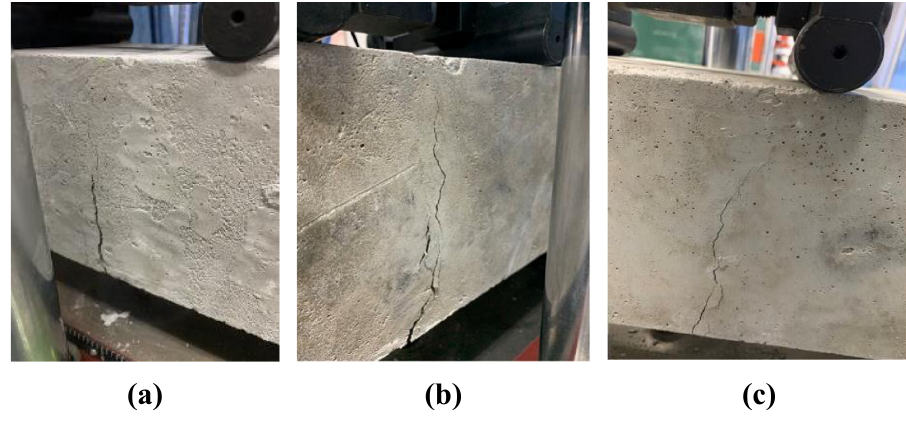
Figure 15: Failure mode of concrete fl exural strength: ( a ) NC, ( b ) PSFC, and ( c ) RSFC.